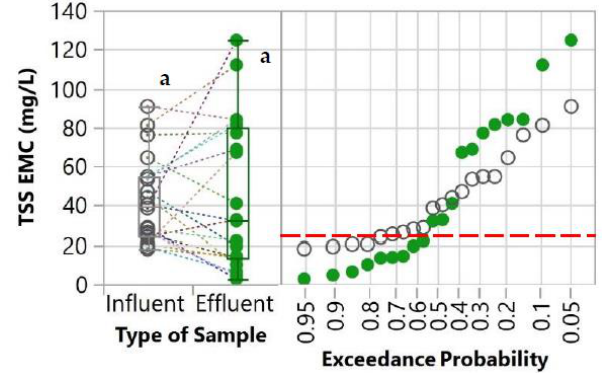
Figure 5. Box plot and normal probability plot of TSS EMC of both influent and effluent. A pair of influent and effluent EMCs from the same storm event and catch basin are connected with dot lines. Different lowercase letters (a and b) indicate significant differences between influent and effluent ( p < 0.05). The red horizontal dashed line represents water quality goals [34].